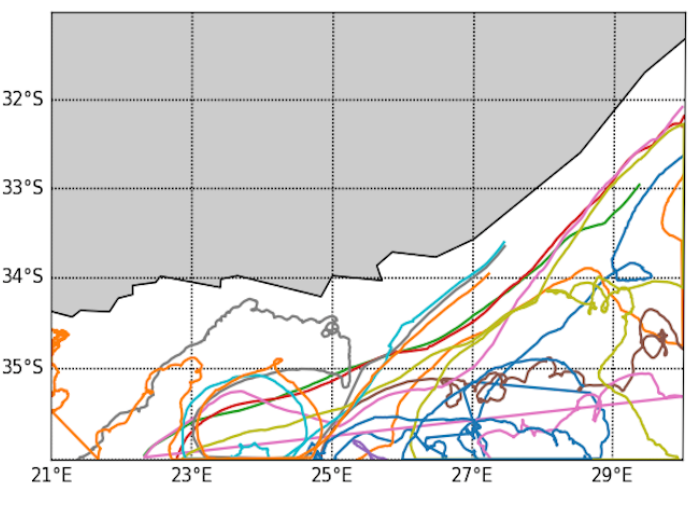
Figure 4. Trajectory of drifters used for performance evaluation: Over the three considered period. This dataset contains N = 6451 points of measurement of current velocity u i at position p i and time t i . For benchmarking purpose, we compare different current product using mean square error (MSE) ∑ N (cid:107) U ( p ) − u (cid:107) 2 where MSE ( U ) : = 1 . i , t i i i = 1 N 2